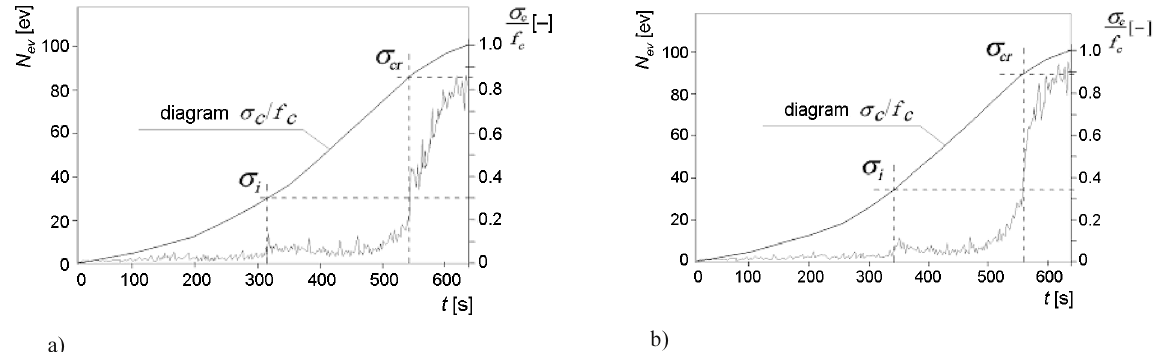
Fig. 9. AE event rate Nzd, referred to relative compressive stress σ c /f c , versus failure time for self-compacting concrete: